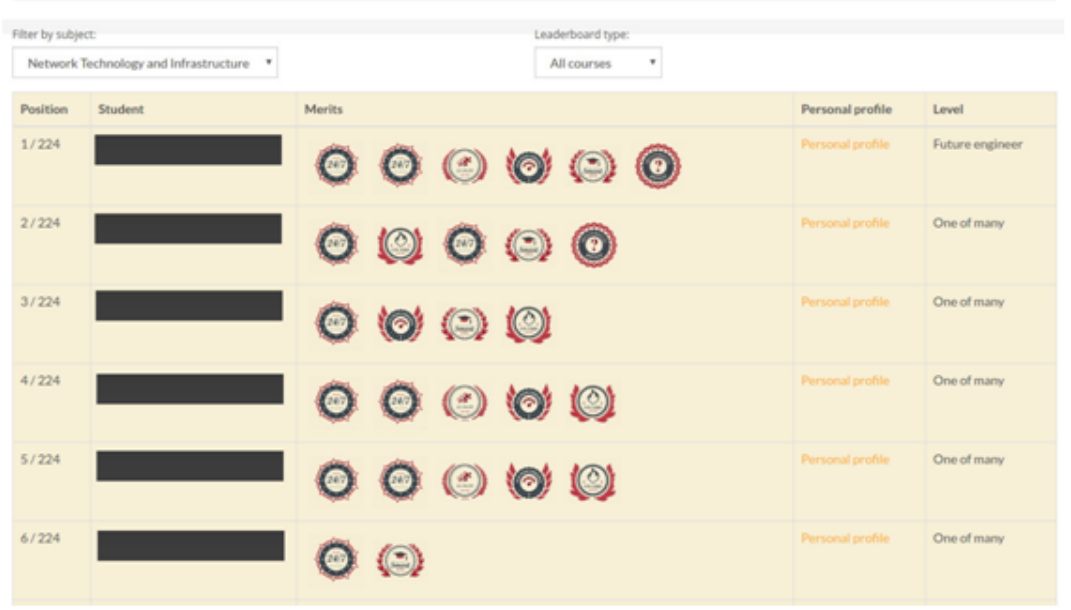
Figure 2. Top 6 positions of the leaderboard, filtered by